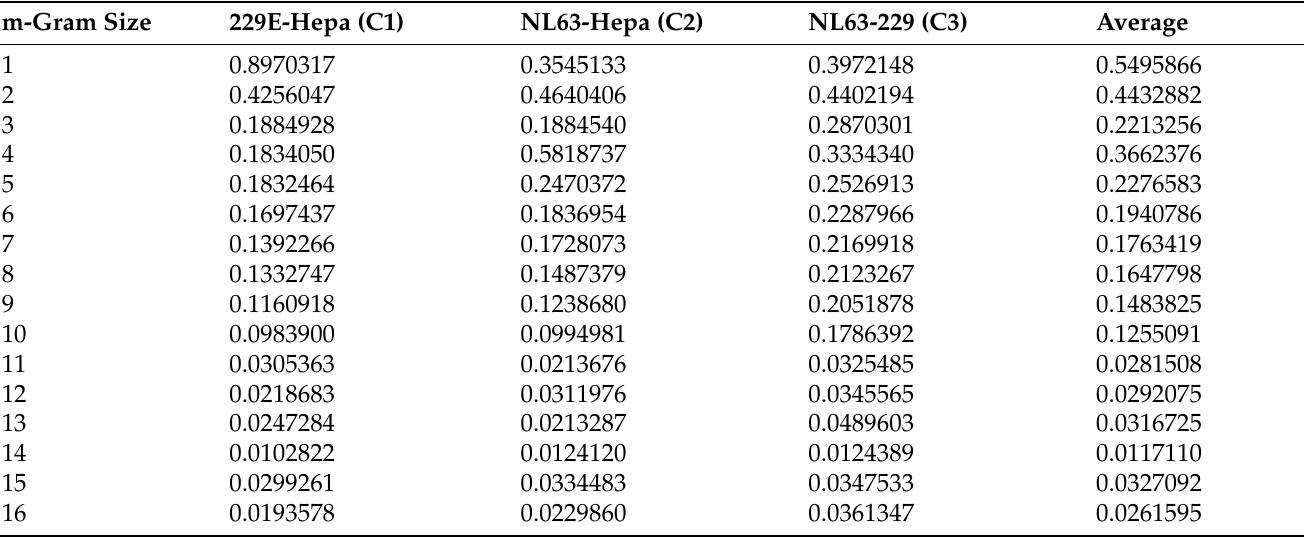
Table 3. Running times at the calculation of the distance scores (229E-Hepa ( C1 ), NL63-Hepa ( C2 ), and NL63-229 ( C3 )) of the Doc2Vec vectors of the three viruses and the average of these running times in seconds using different m-gram